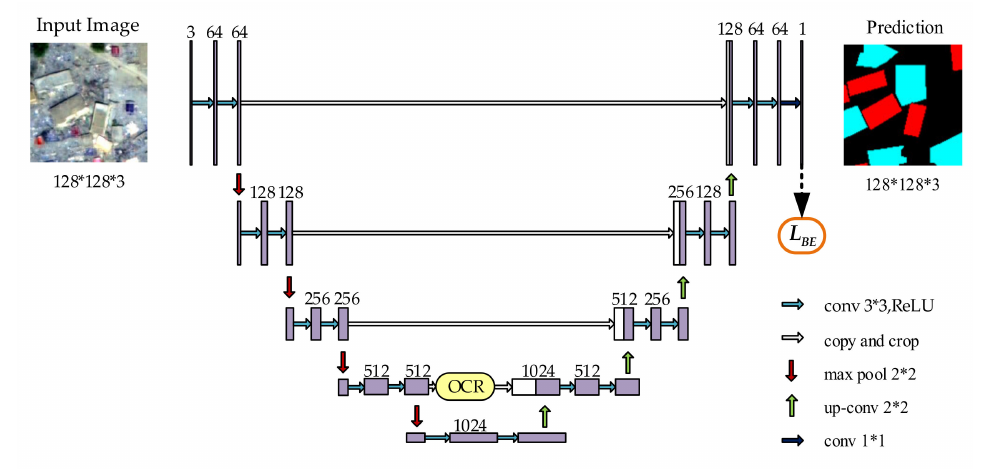
Figure 3. Overall structure of the proposed OB-UNet.